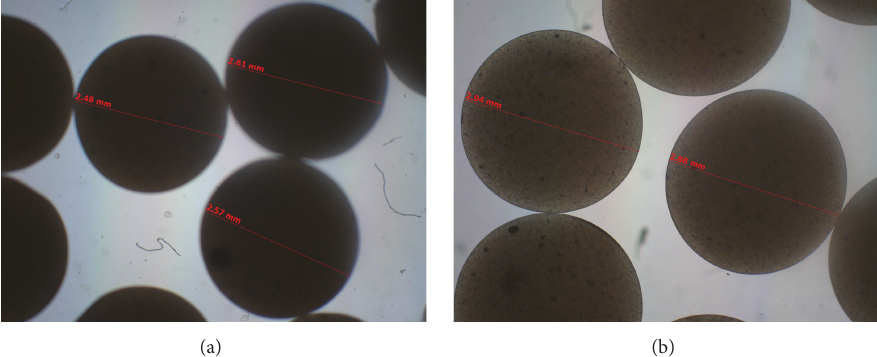
Figure 1: The size of the beads measured using optical microscopy, 5 × 10: (a) alginate beads and (b) alginate beads coated with chitosan.